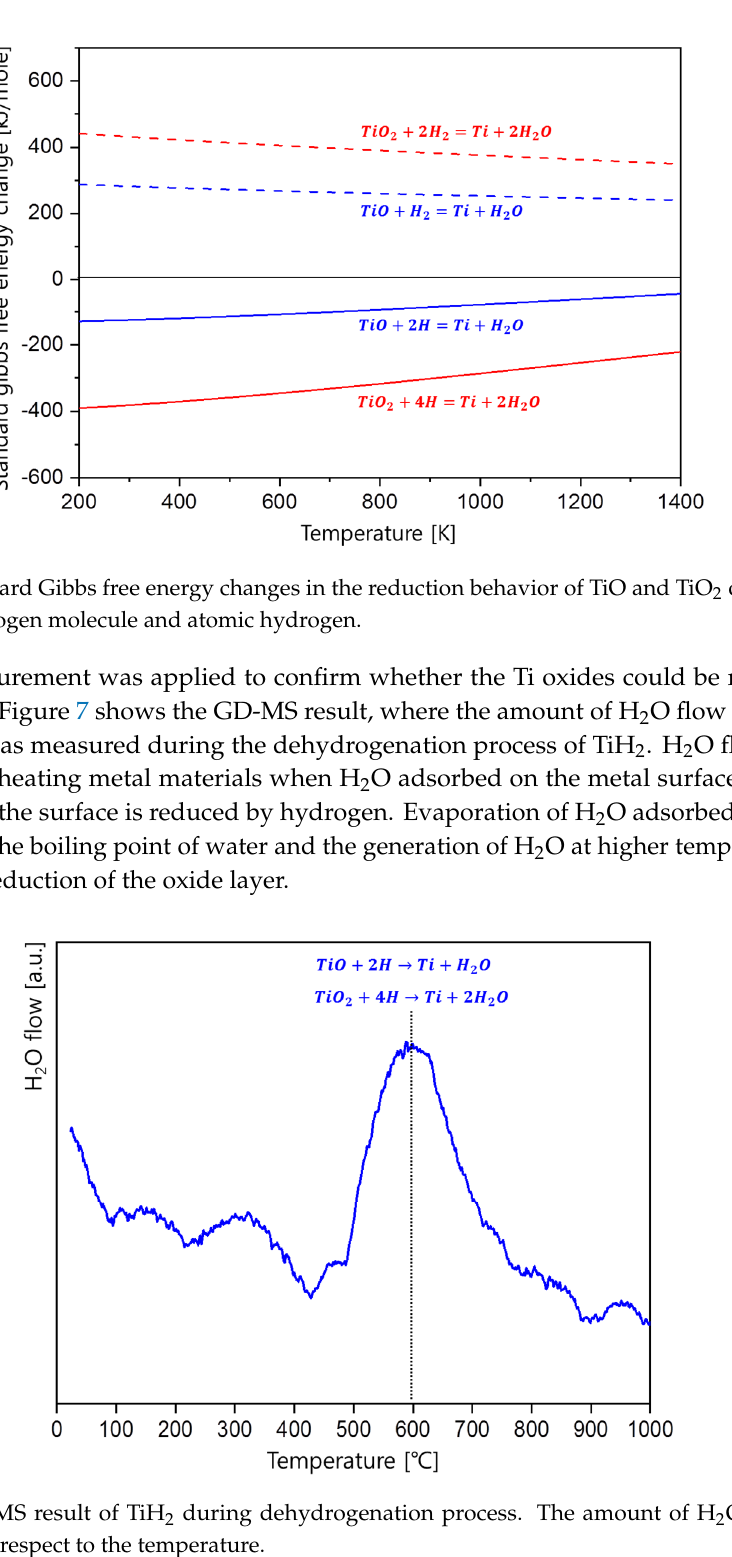
Figure 7. GD-MS result of TiH 2 during dehydrogenation process. The amount of H 2 O flow was measured with respect to the temperature.